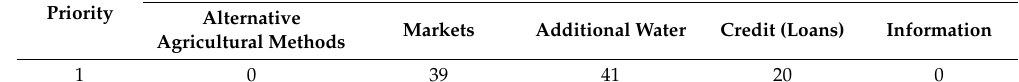
Table 3. Prioritization of issues by the farmers. Priority 1 is more important than 2, which is more important than 3, and so on.